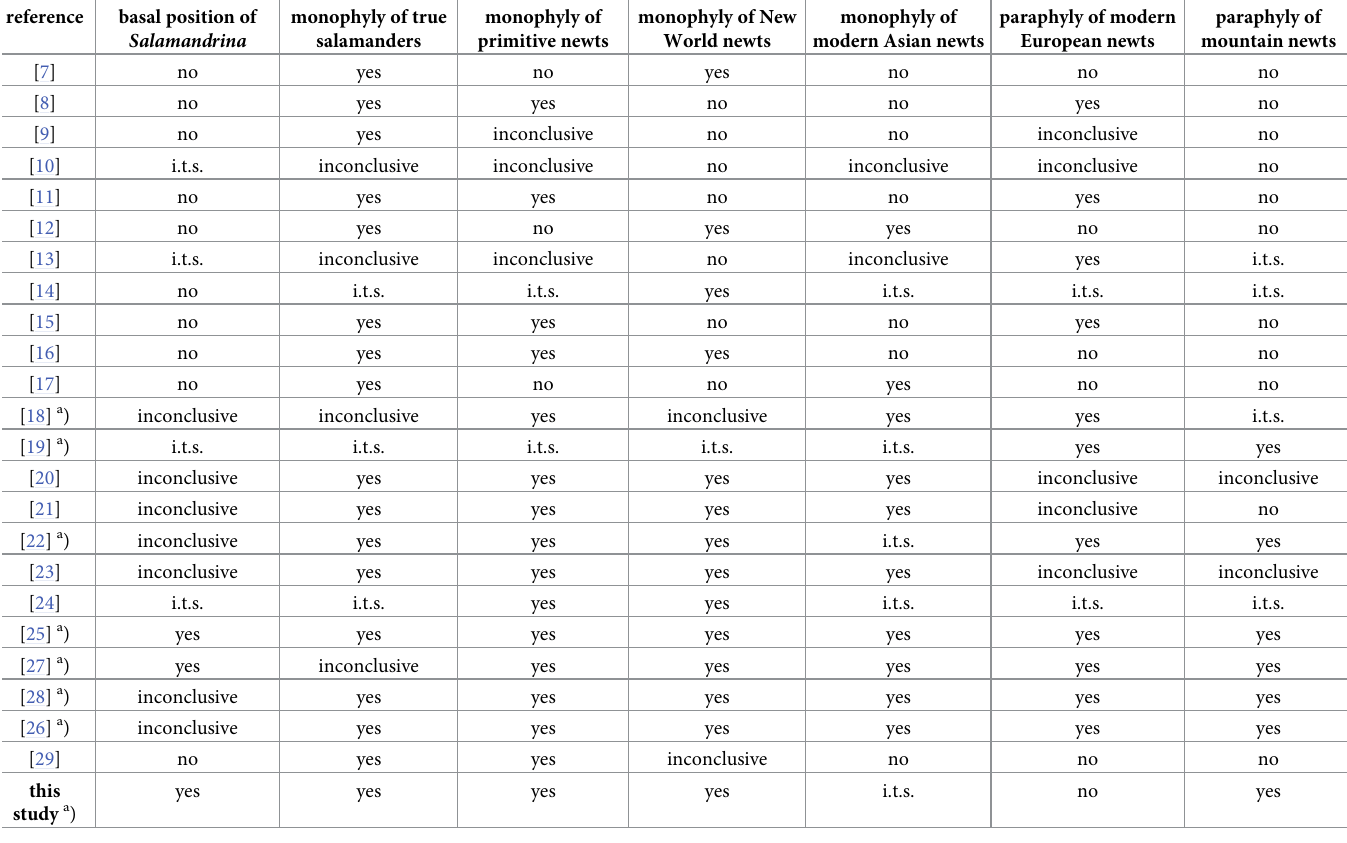
Table 3. Presence of tree topologies (referring to [25]) in published Salamandridae